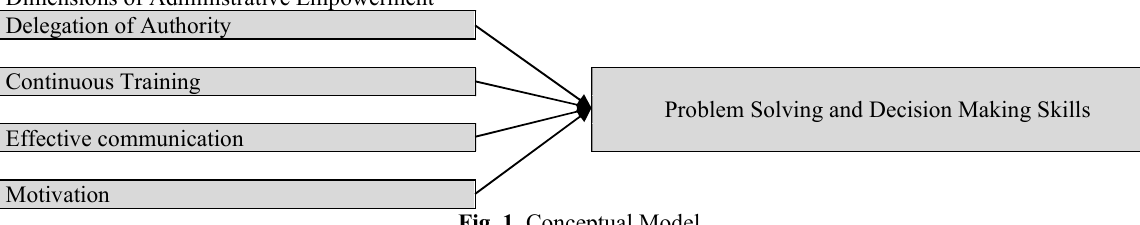
Fig. 1. Conceptual